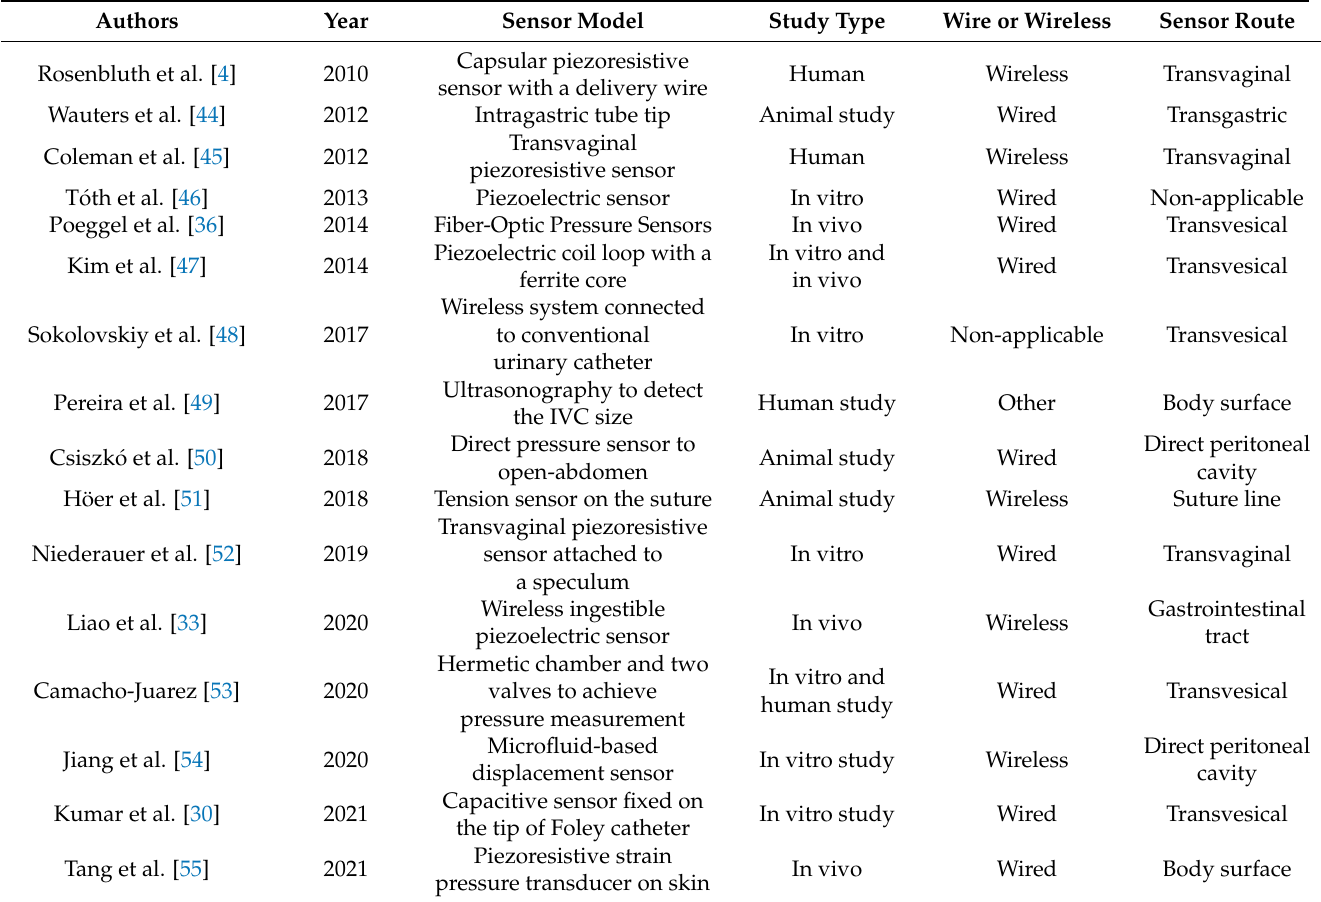
Table 3. The characteristics of included studies about novel intra-abdominal pressure sensor systems.